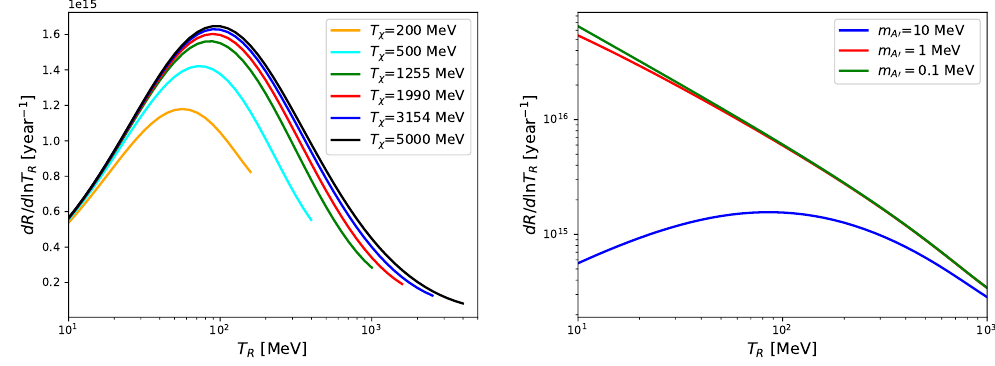
Figure 5 . Left panel: the differential recoil rate with fixed incident DM kinetic energy as indicated in the legend, where we have chosen m χ = 0 . 32 MeV, m A 0 = 10 MeV, g 0 = 1 and (cid:15) = 1 . Right panel: the differential recoil rate for three different values of m A 0 , where we have taken incident DM kinetic energy T χ = 1255 MeV, m χ = 0 . 32 MeV, g 0 = 1 and (cid:15) = 1